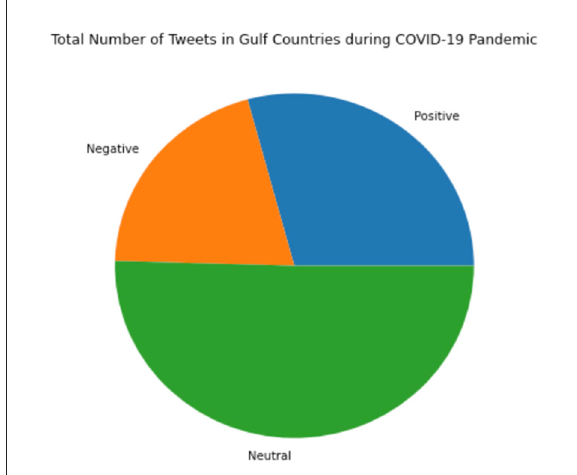
FIGURE2 Total Number of Tweets in Gulf Countries during the COVID-19